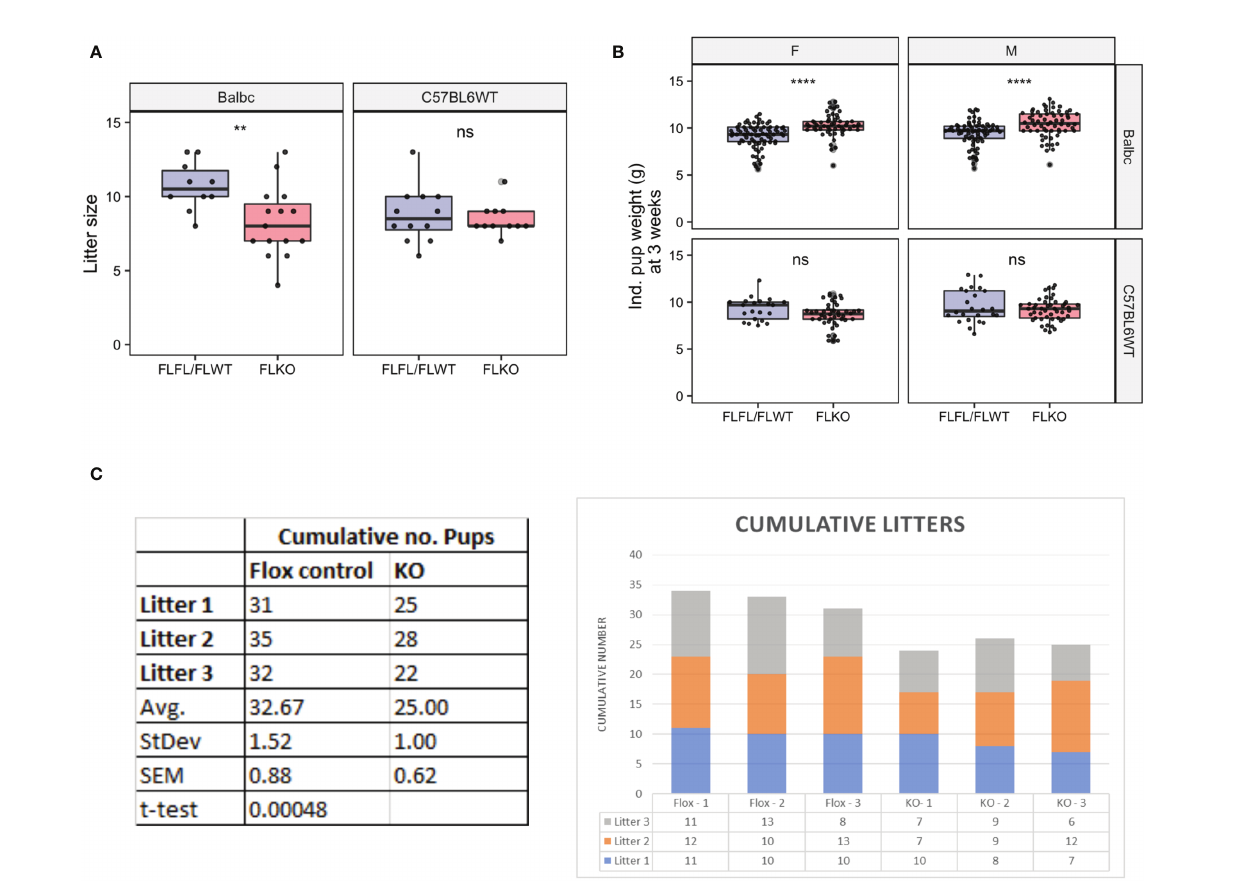
FIGURE 7 | Assessment of long-term fertility outcome in FLFL/FLWT ( Pgr f/f or Pgr f/+ ) and FLKO ( Pgr d/d ) in allogeneic and syngeneic mating strategy. (A) Individual litter size from female of FLFL/FLWT and FLKO mated with either allogeneic (Balb/c) or syngeneic (C57) male. (B) Weight of male or female 3 week old weanlings born to FLFL/FLWT and FLKO from allogeneic or syngeneic mating. **p < 0.01, ****p < 0.0001, ns, not-signi fi cant. (C) Cumulative numbers of pups across three allogeneic pregnancies in controls (Flox-1 to Flox- 3) and FLKO animals (KO-1 to